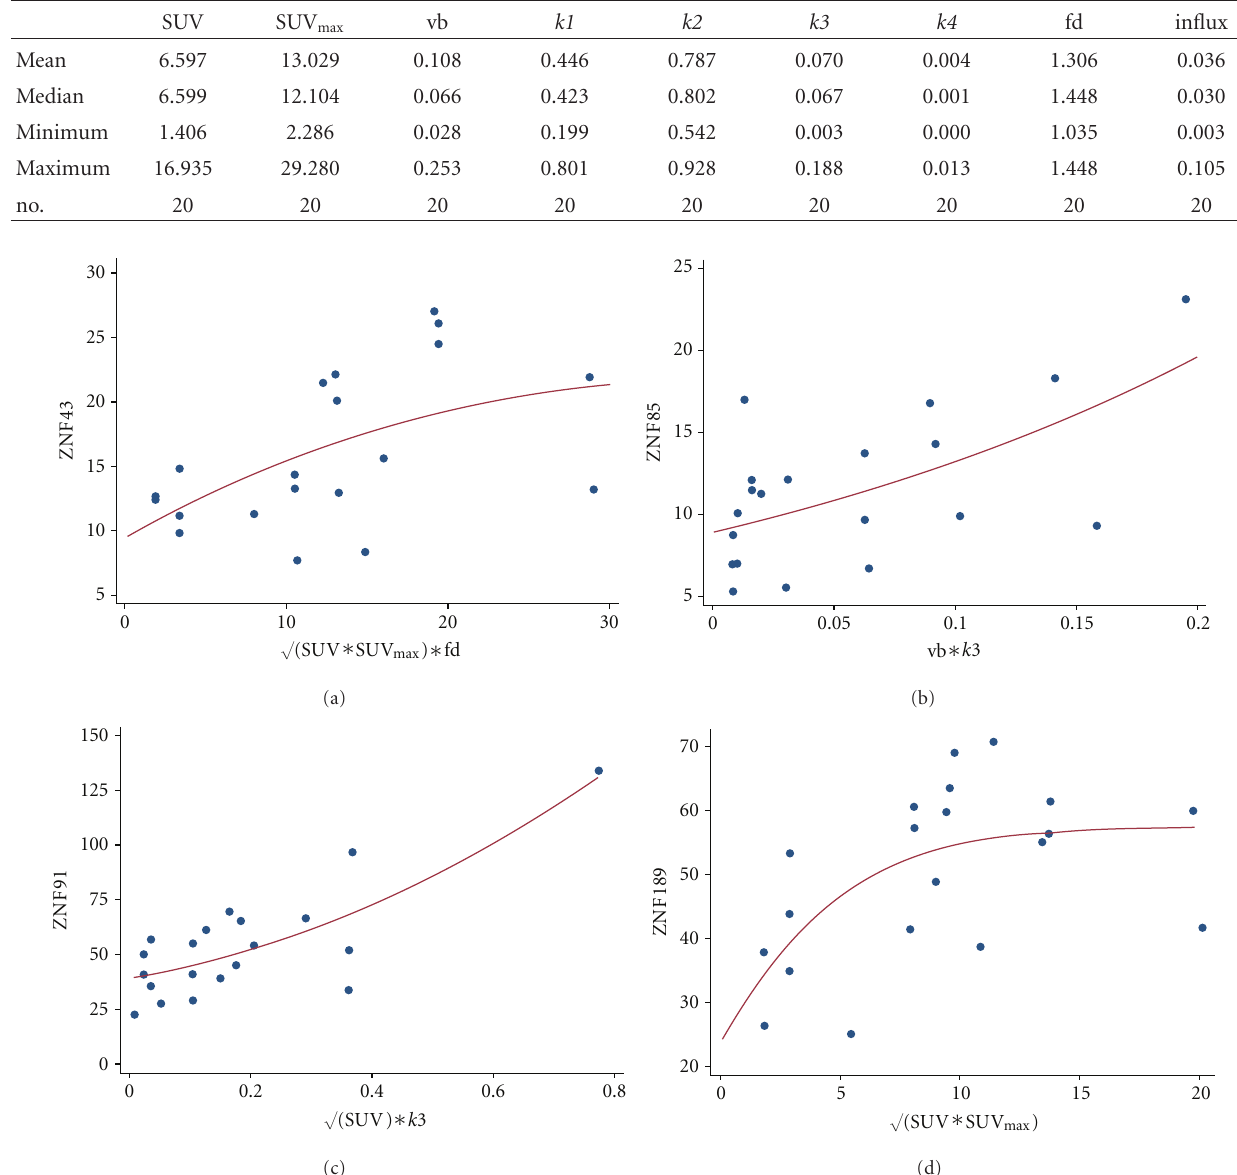
The PET variables used for the nonlinear regression func- tions are shown on the x -axis in Figure 1, while the y -axis reflects the corresponding gene expression data (unit for gene expression data: